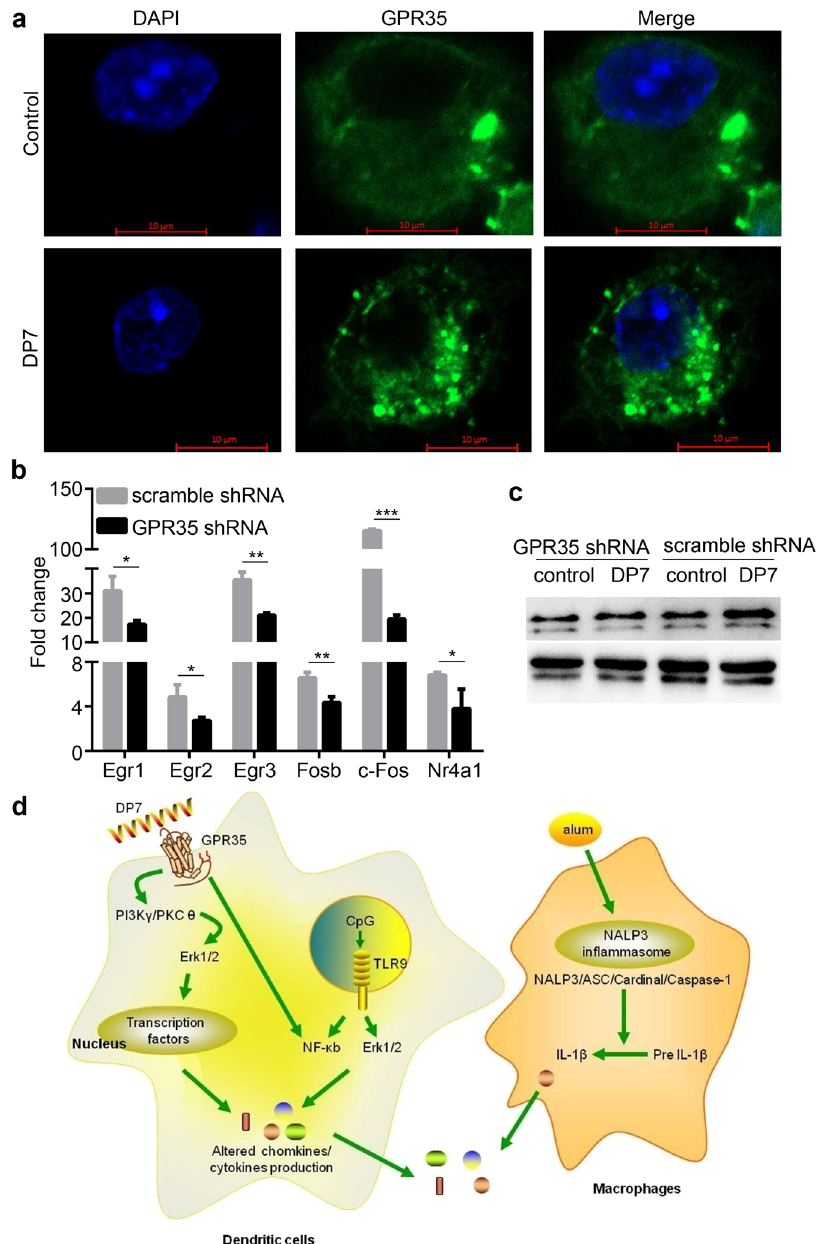
Fig. 7 GPR35 was essential for the activity of the peptide DP7. a Representative fl uorescence images of GPR35 internalization induced by stimulation with DP7 (40 μ g/ml) for 30 min in BMDCs. Control indicates the nonstimulated group. b , c GPR35 was inhibited by transfection of JAWSII cells with an shRNA lentivirus, which were then selected with puromycin for 5 days. After stimulation with the peptide DP7 (40 μ g/ml) for 30 min, cells were lysed for the detection of transcription factor expression by RT-qPCR (Data are representative of three experiments with three replicates each; Statistical analyses were done using the t-test.) ( b ) or Erk1/2 phosphorylation by western blotting ( c ). Control indicates the nonstimulated group. d A simpli fi ed schematic of the mechanisms of action of alum/CpG/DP7 in dendritic cells and macrophages. Bars represent means and SEM. * P < 0.05, ** P < 0.01, *** P <